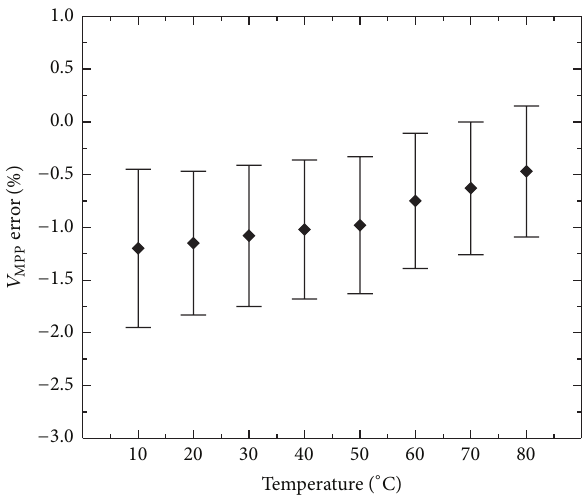
Figure 8: The percentage error on 𝑉 estimation and the corre- MPP sponding error bar for each considered temperature